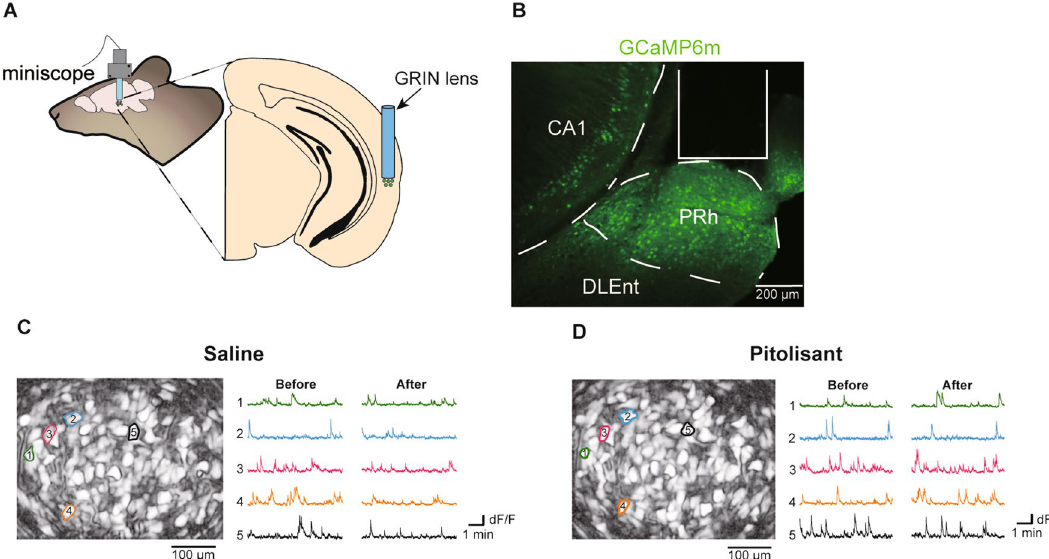
Figure 1. In vivo Ca 2+ imaging from perirhinal cortex neurons. (A ) GRIN lens is implanted above the PRh, and images are acquired using the GRIN lens and miniscope. ( B ) A representative image depicting the GRIN lens position and GCaMP6m expression in PRh neurons. ( C , D ) Representative correlation images (left) and extracted Ca 2+ traces before and after saline ( C ) or pitolisant ( D ) injection. DLEnt, dorsolateral entorhinal cortex; GRIN, gradient-index; and PRh, perirhinal